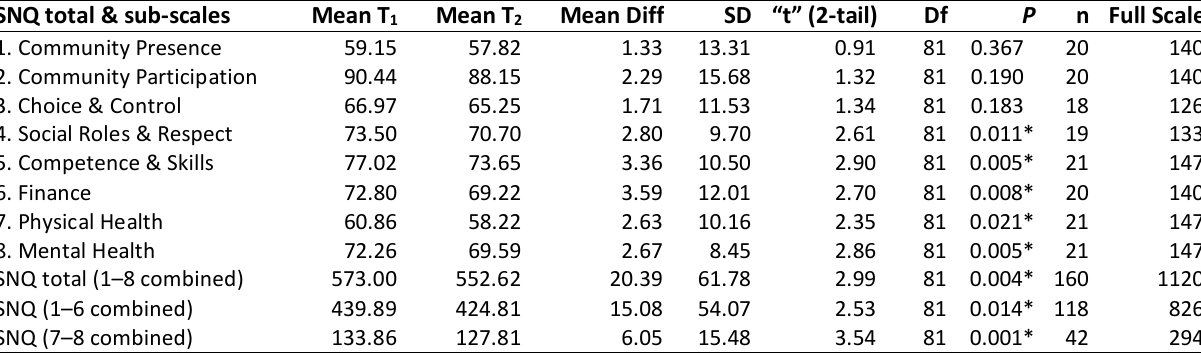
Table 5. Test-retest reliability drift for SNQ total and sub-scales. SNQ total & sub-scales